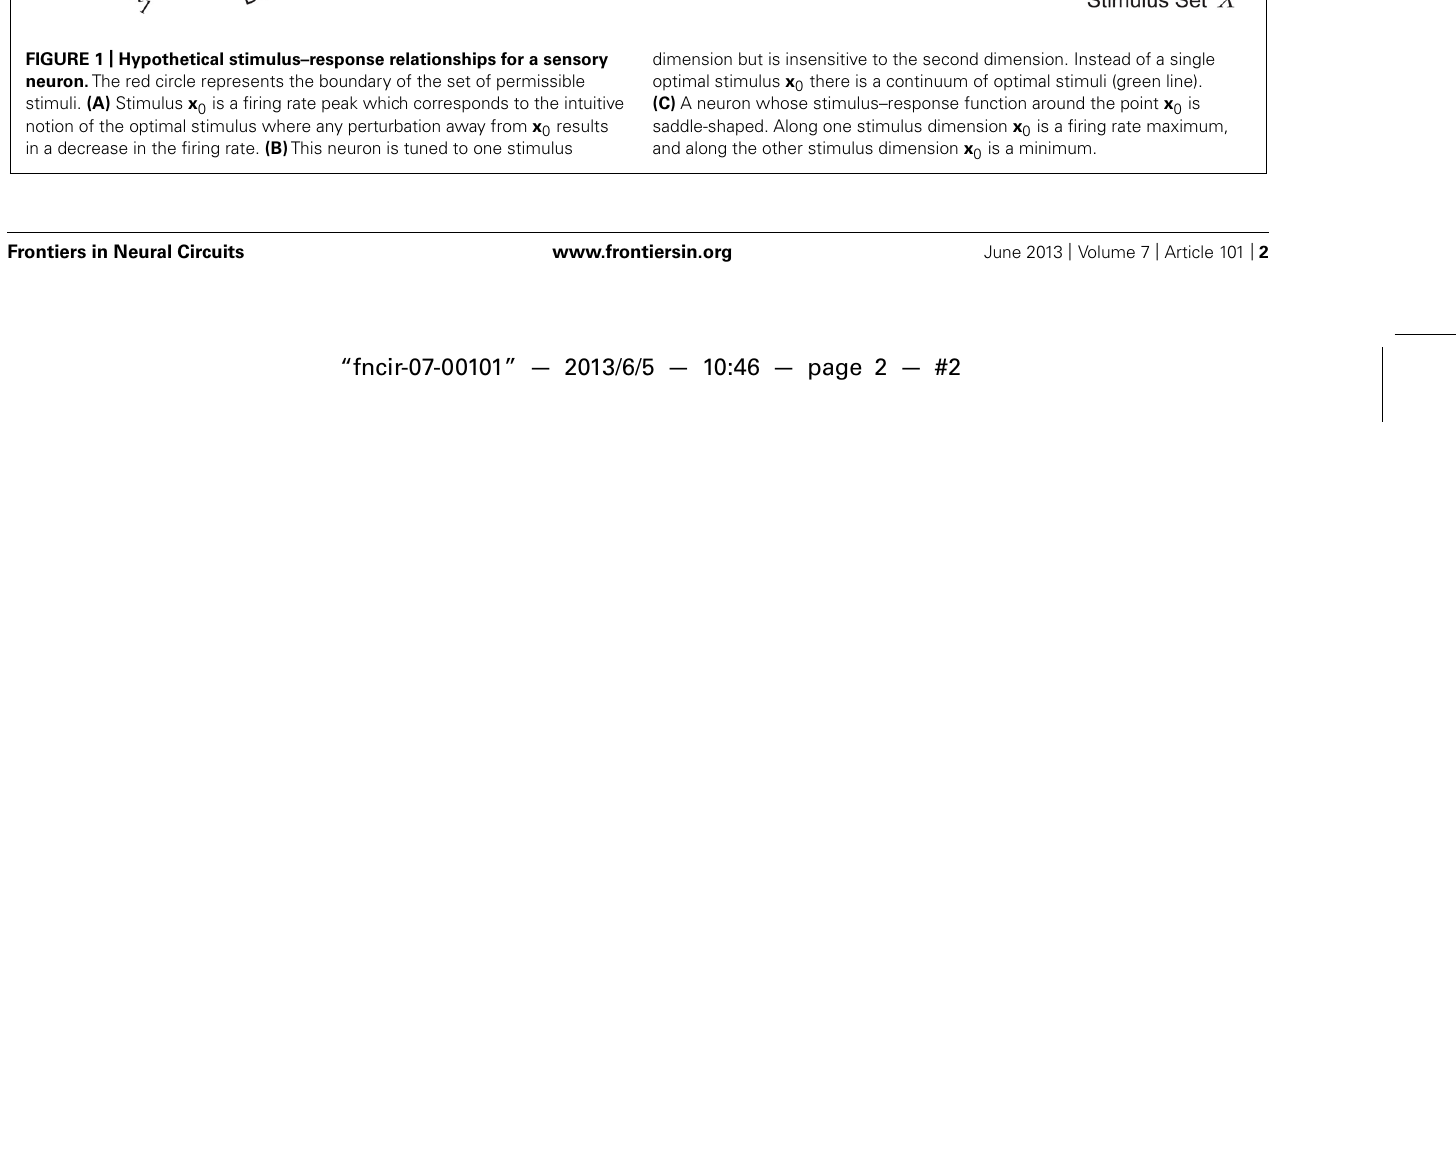
FIGURE 1 | Hypothetical stimulus–response relationships for a sensory neuron. The red circle represents the boundary of the set of permissible stimuli. (A) Stimulus x 0 is a firing rate peak which corresponds to the intuitive notion of the optimal stimulus where any perturbation away from x 0 results in a decrease in the firing rate. (B) This neuron is tuned to one stimulus